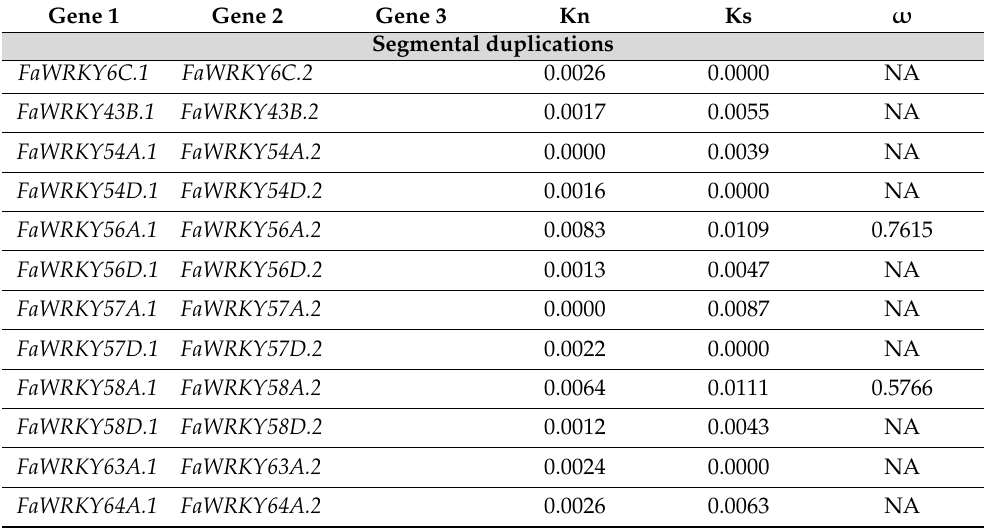
Figure 4. Chromosome mapping of the Fragaria × ananassa WRKY gene family within each subgenome. Segmental duplicated gene pairs (syntenic paralogs) share the same colors. Non- syntenic gene duplicates are underlined. Tandemly duplicated gene clusters are colored in orange. Ruler size is in Megabases. Table 2. FaWRKY gene duplications. Nucleotide substitution values (Kn, Ks) and ω for tandemly duplicated genes were not provided by Synmap2. PAL2NAL was used to calculate Kn and Ks of the non-syntenic paralogs. ω values were not calculated if Ks <